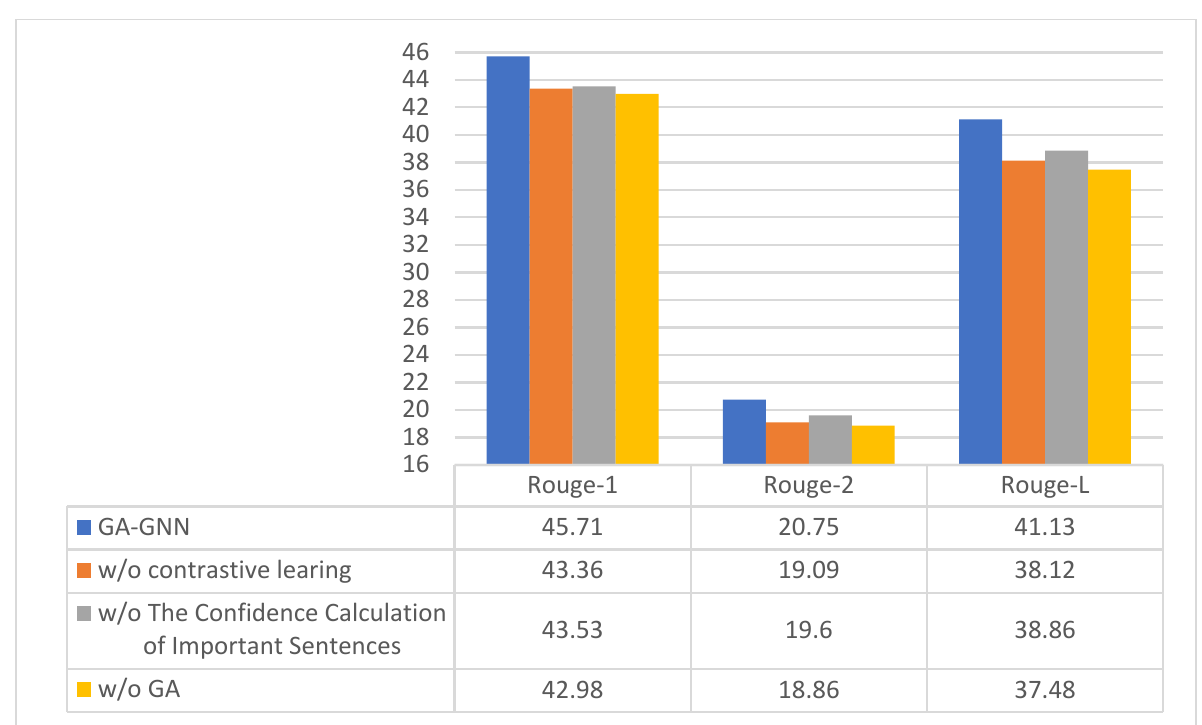
Figure 3. Experimental results of the effect of different modules on model performance.